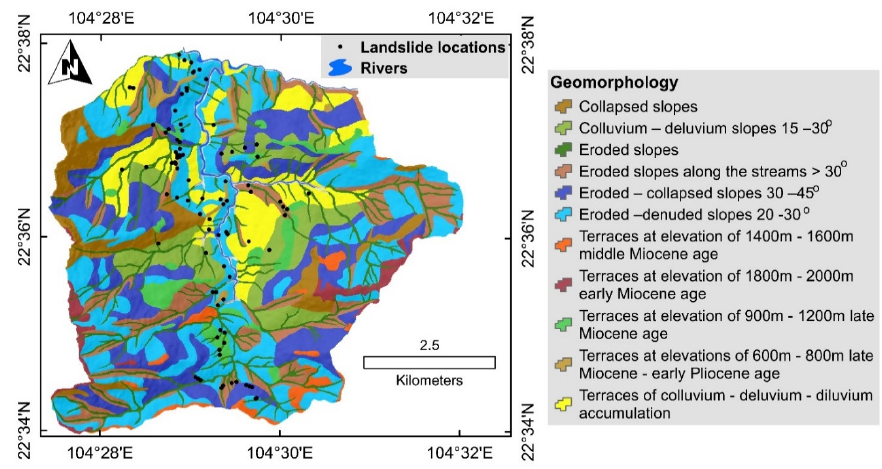
Figure 4. Geomorphology units of the Nam Dan commune.